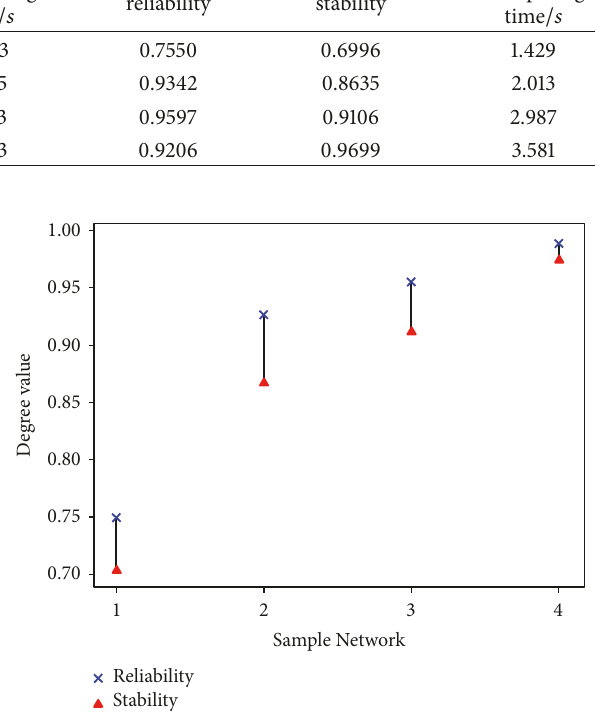
Figure 3: The reliability stability of sample